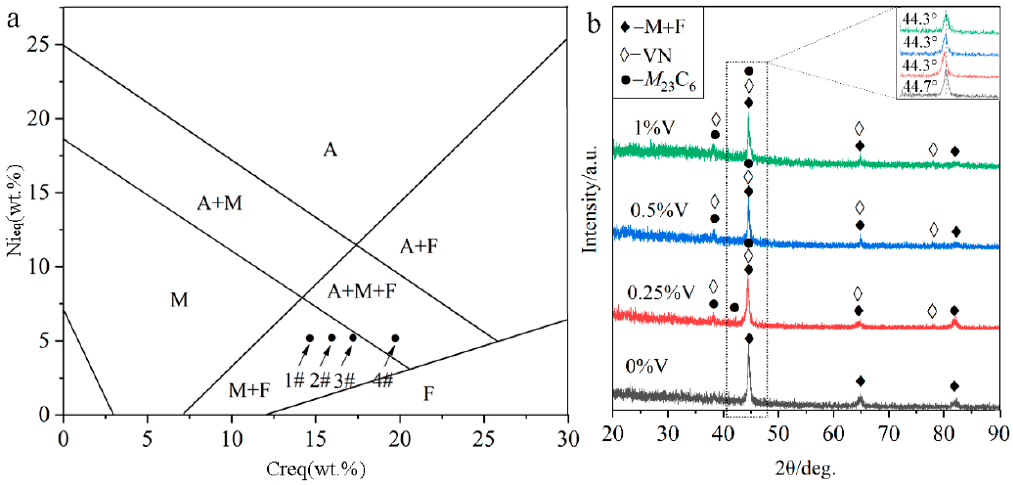
Figure 2. Phase constituent of the laser-cladded MSS coatings with different V contents: ( a ) Schaeffler phase diagram; and ( b ) XRD pattern.